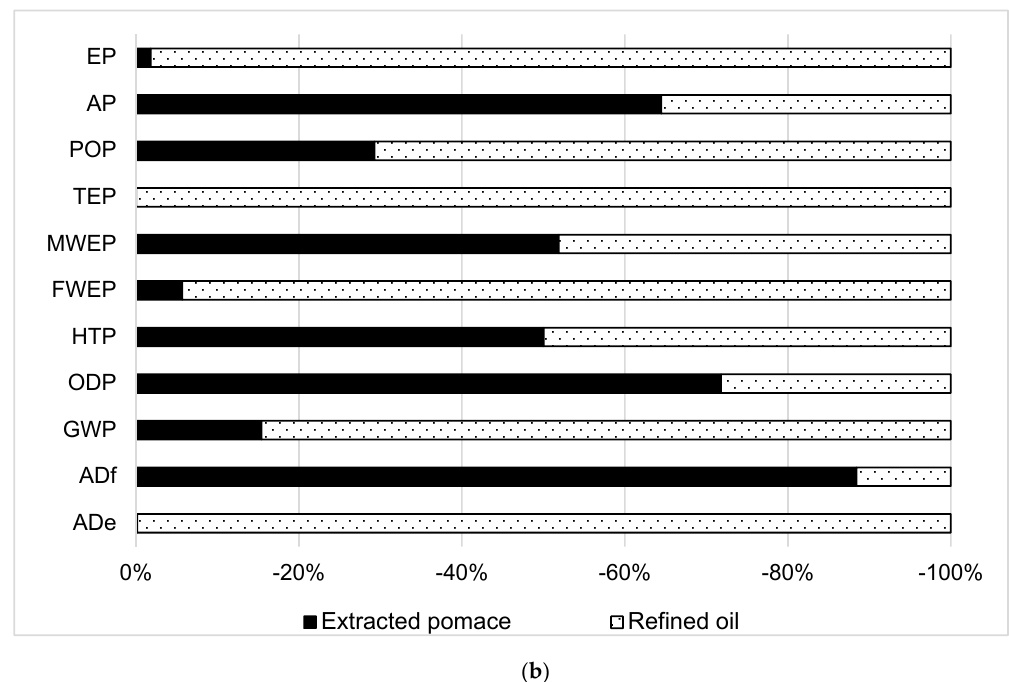
Figure 5. Percentage contribution to the impacts for crude olive pomace oil extraction, burning a fraction of the extracted olive pomace (OPOE-B): ( a ) positive contribution; ( b ) credits.